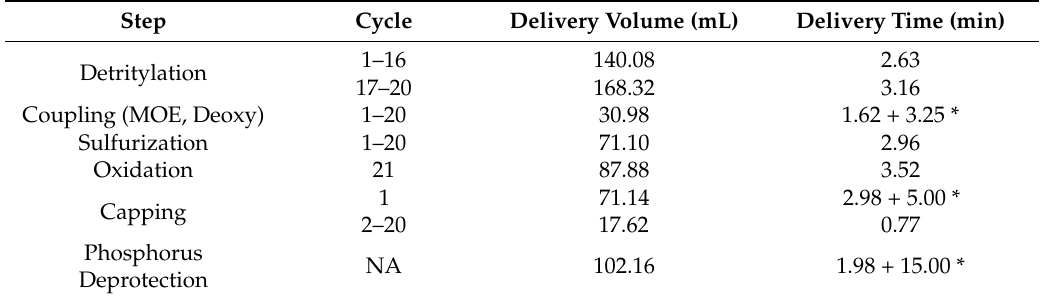
Table 4. Reaction parameters for 2.2-mmol scale synthesis on the AKTA OligoPilot 100